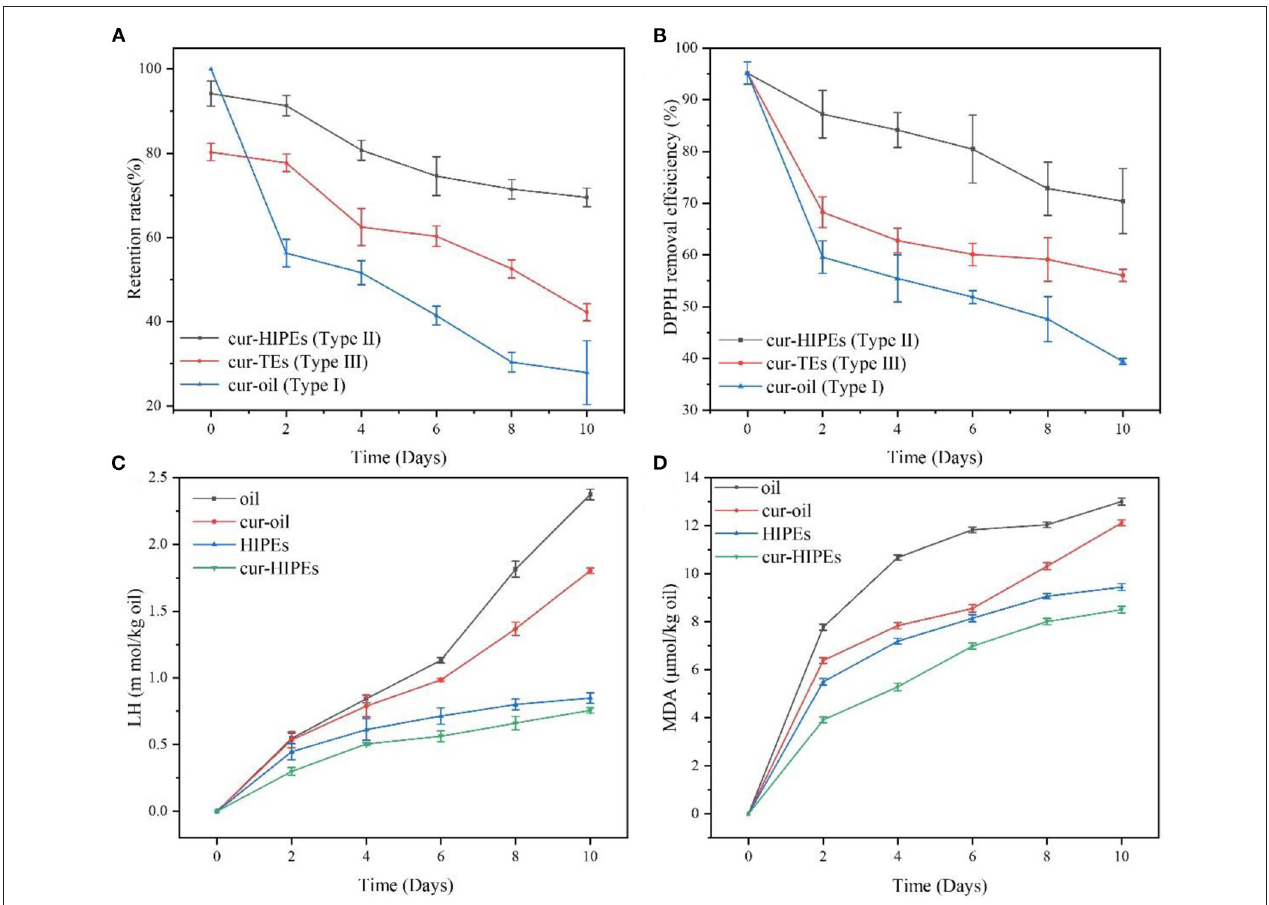
FIGURE 6 | Evolution of lipid hydroperoxides (LHs) (A) , malondialdehyde (MDA) (B) retention rate (C) , and 1,1-diphenyl-2-picrylhydrazyl (DPPH) removal efficiency (D) under accelerated storages at 60 ◦ C for 10 days.